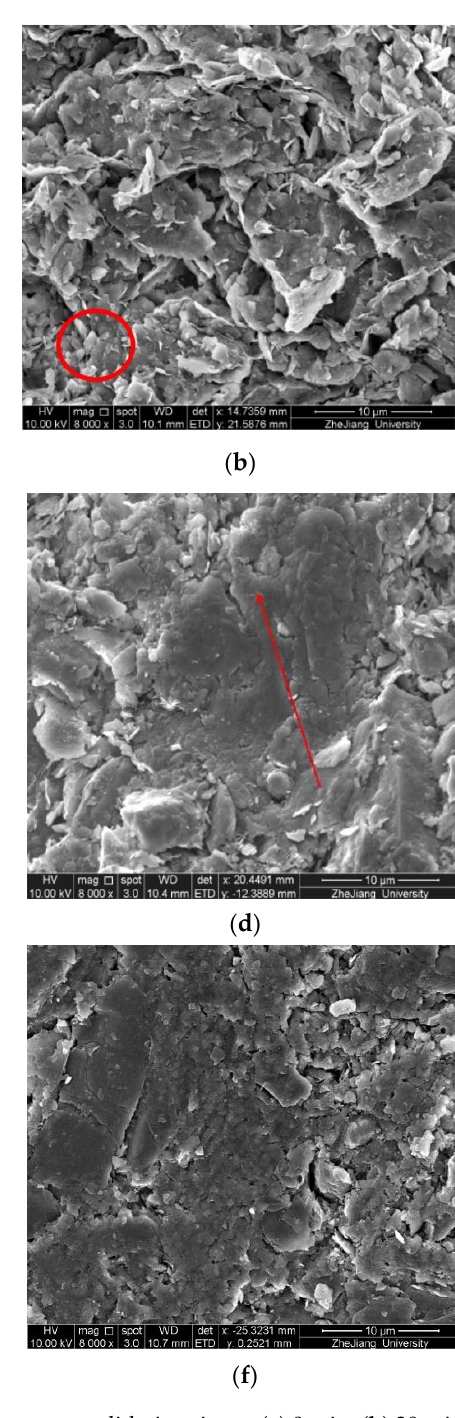
Figure 3. Microstructure of soil samples under different consolidation times: ( a ) 0 min; ( b ) 30 min; ( c ) 60 min; ( d ) 240 min; ( e ) 720 min; ( f ) 1440 min.